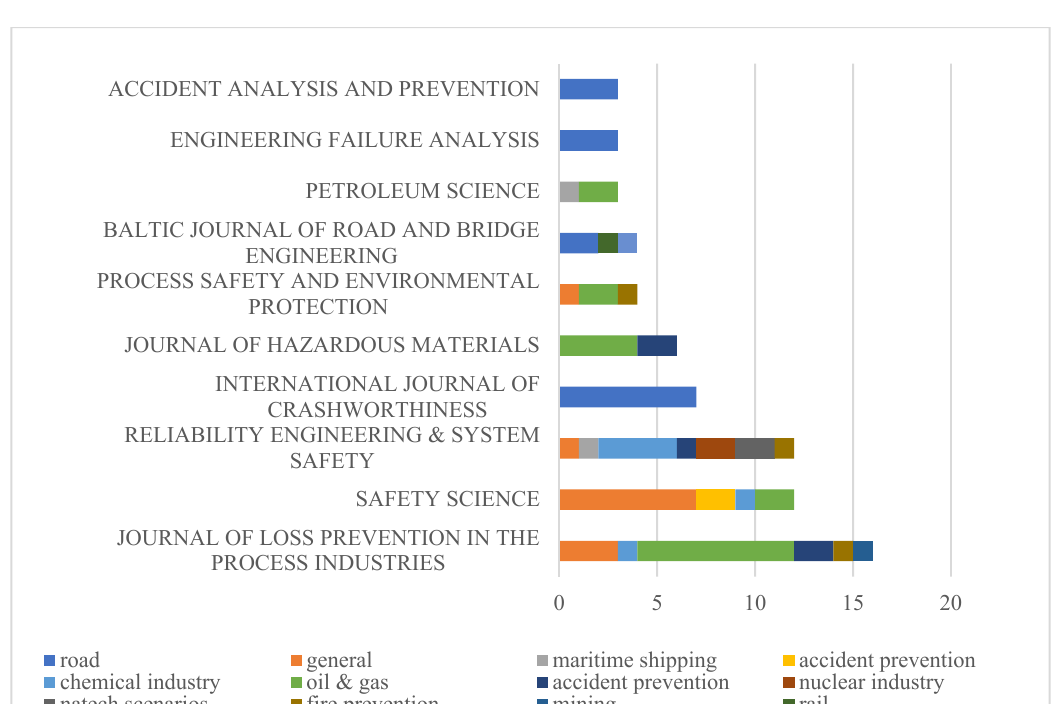
Figure 8. Number of publications by journal.